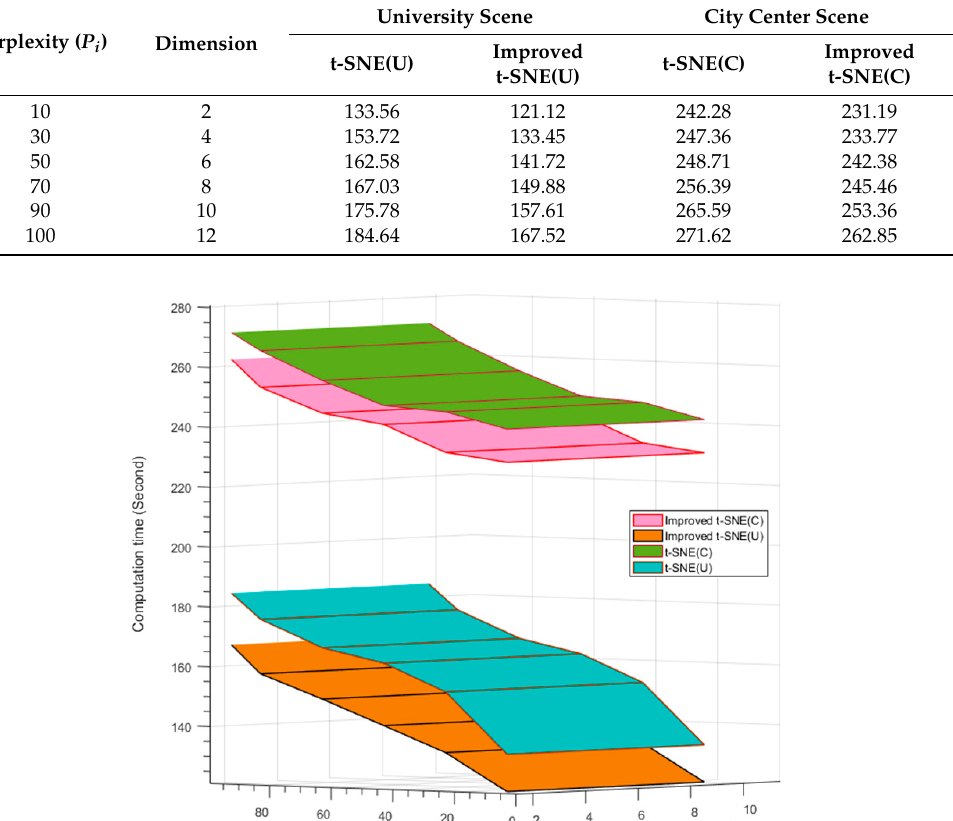
Figure 8. Comparison of computation time between improved t-SNE and t-SNE for university scene (U) and city center scene (C). Table 6. Computation time of improved t-SNE and t-SNE for university scene (U) and city center scene (C).